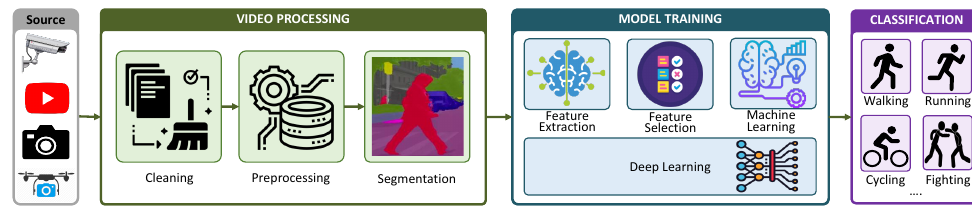
Figure 3. Human Action Recognition